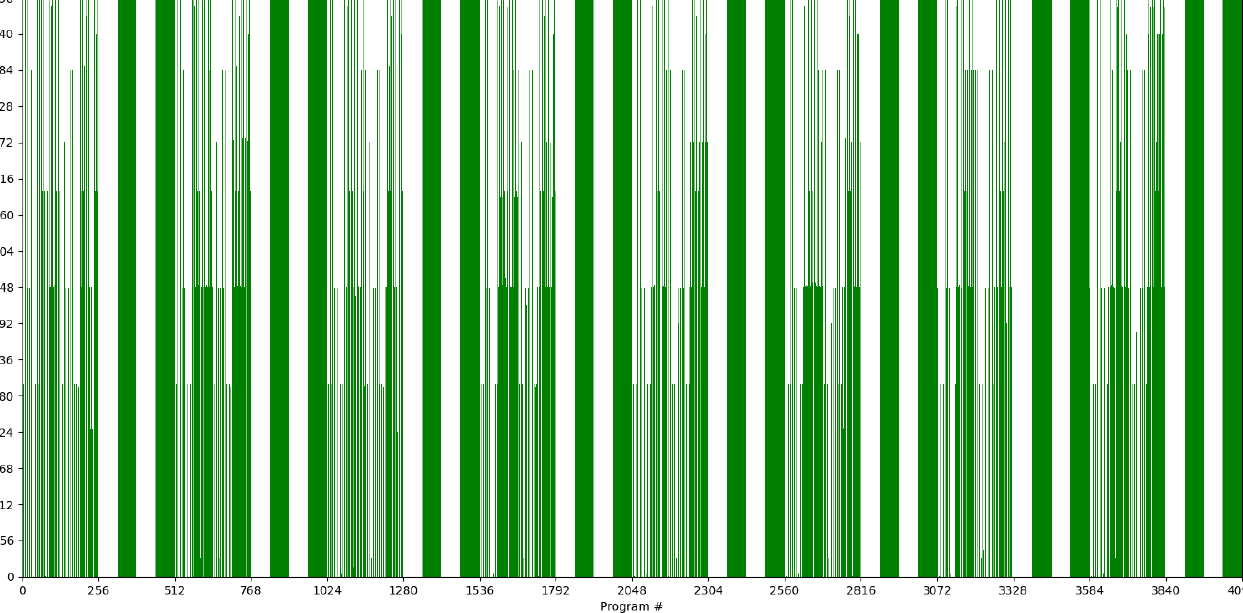
Figure 5. QPULBA( m , n , d , t , c ) universal distribution for Case m = 2, n = 2, d = 1, t = 12, c = 12, showing the tape output for the entire space of programs.